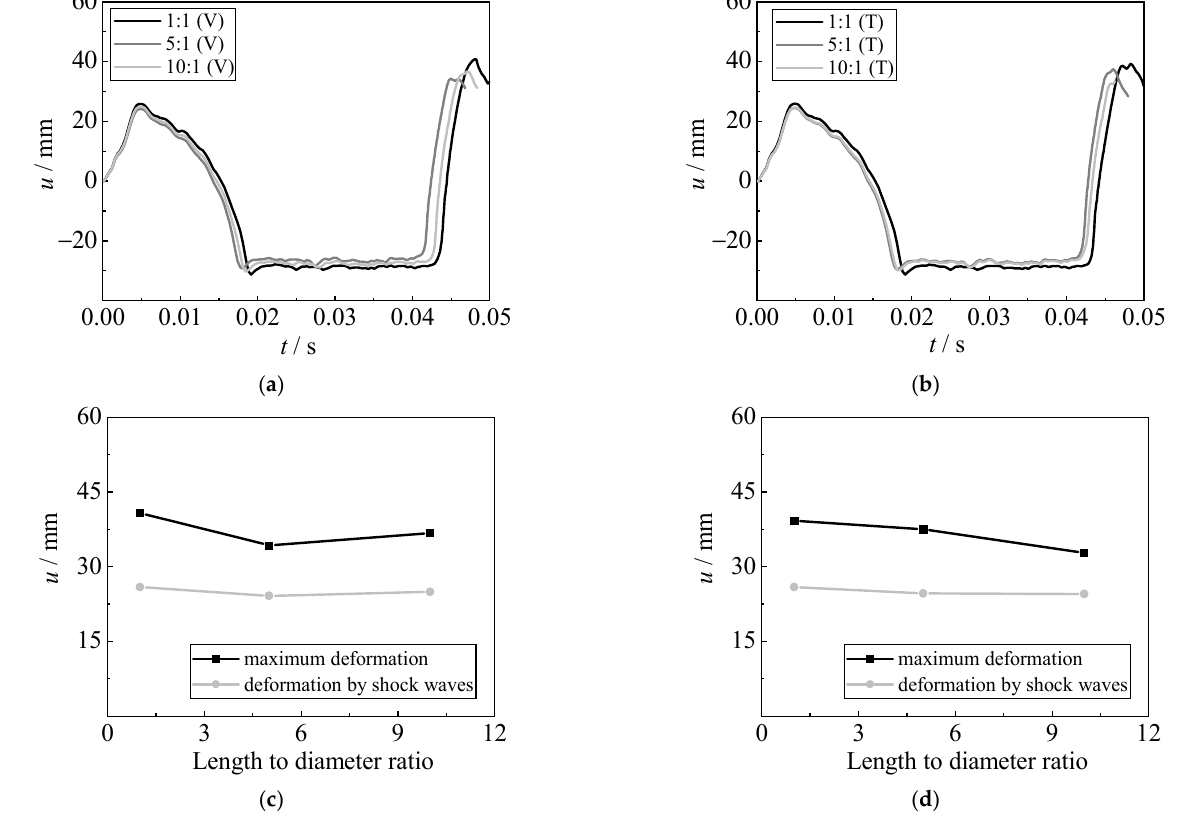
Figure 21. Effect of shape and position of the charge. ( a ) Displacement time histories (Vertically). ( b ) Displacement time histories (Transversely). ( c ) Deformation (Vertically). ( d ) Deformation (Transversely).